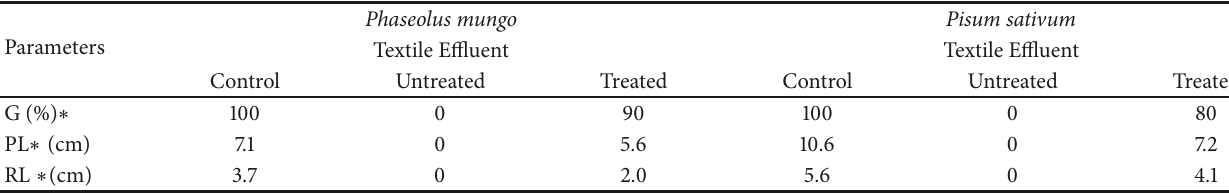
Table 3: Comparison of phytotoxicity of 50% untreated and treated textile effluent with control after 10 days. Parameters